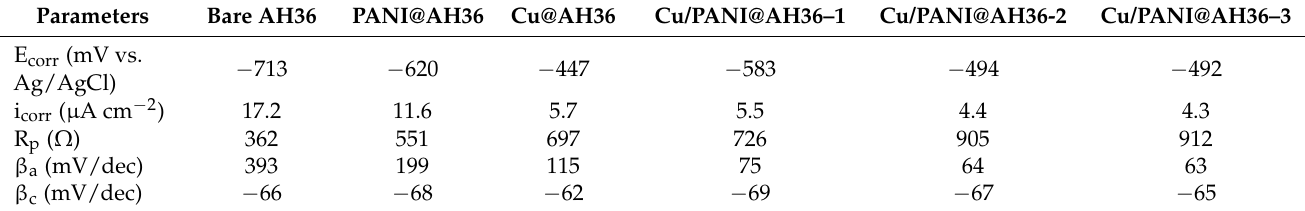
Figure 6. ( a ) Values of the open circuit potential (OCP) and ( b ) Tafel polarization curves ob- tained from the bare AH36, PANI@AH36, Cu @AH36, Cu/PANI@AH36-1, Cu/PANI@AH36-2, and Cu/PANI@AH36-3 steels. Table 2. Electrochemical parameters from the polarization curves and OPC